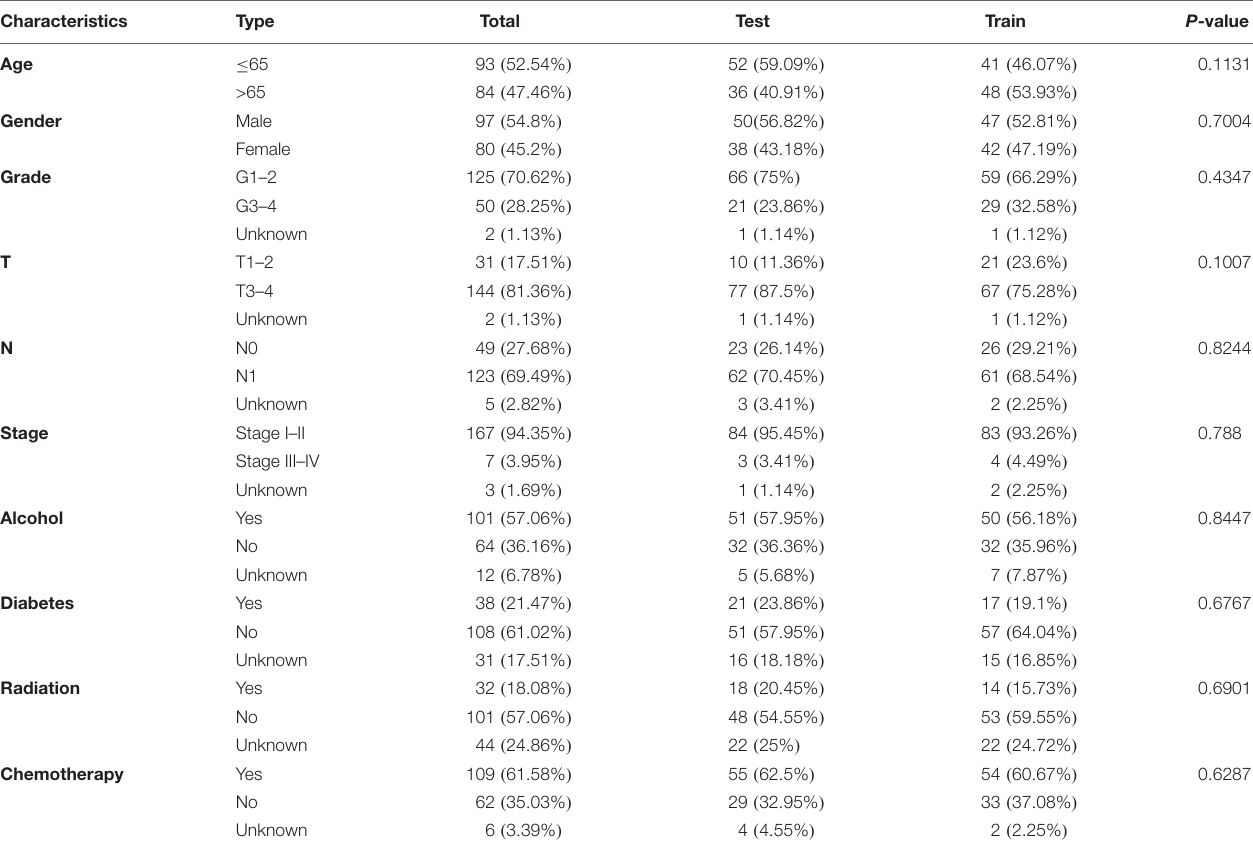
TABLE 1 | Clinical characteristics of the pancreatic cancer patients.